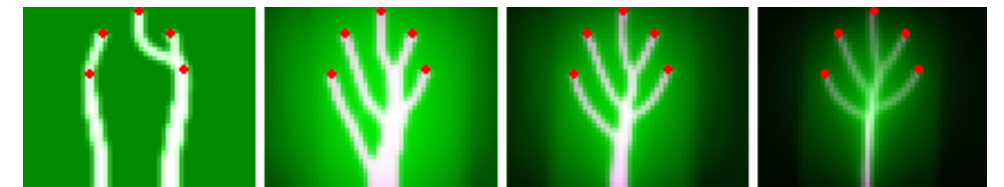
Figure 3. Convolution with radial reciprocal kernel A α α = 0,1/4,1/2,1 (left to right). The resulting tree from five point loads is shown in